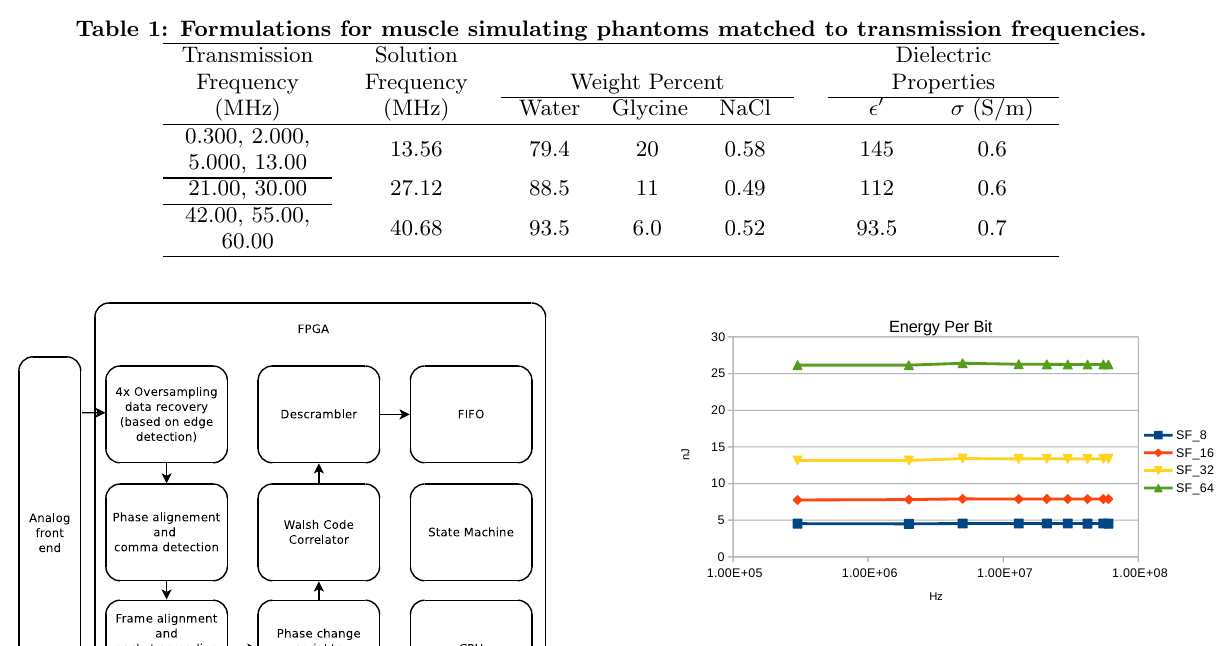
Figure 7: Transmitter power consumption vs fre- quency for each IEEE 802.15.6 spreading factor (SF) factor approximately doubles the packet length. For spread- ing factors of 8, 16, 32 and 64 chips per bit, the transmitter power requirements are approximately 4.5nJ, 7.9nJ,